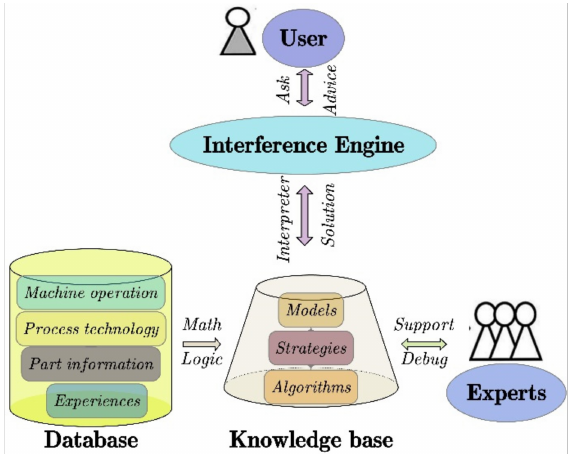
Figure 12. The architecture of